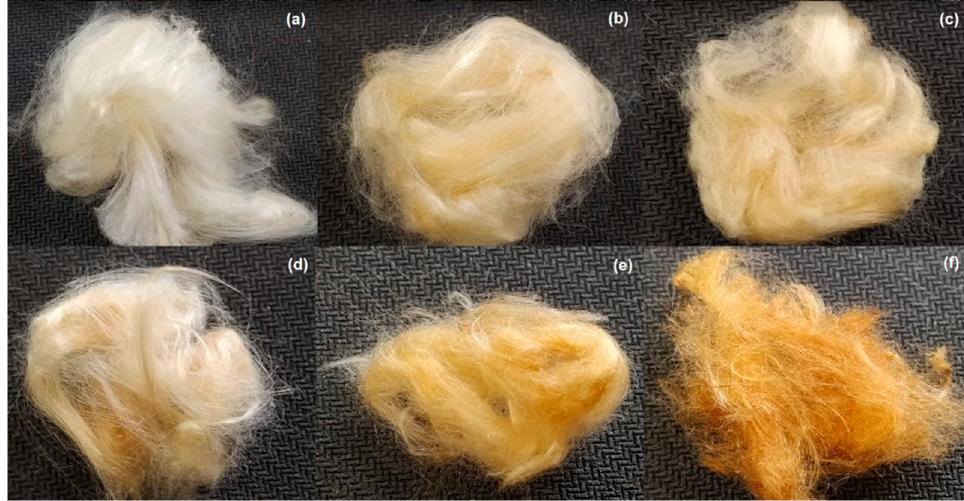
Figure 2. Image of fibers treated whit NaOH and at 150 °C for ( a ) 1 h, ( b ) 2 h, ( c ) 3 h and 200 °C for ( d ) 1 h, ( e ) 2 h, ( f ) 3 h.